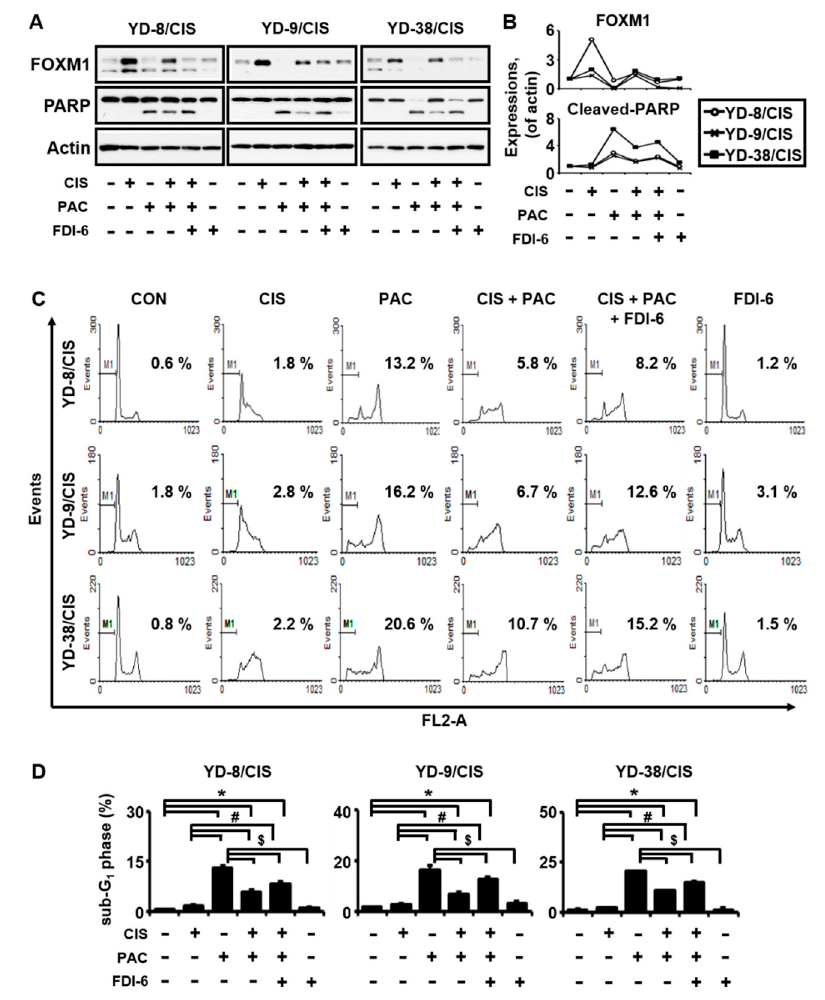
Figure 3. Cisplatin (10 µ g / mL) weakens the chemical sensitivity of paclitaxel (0.1 µ g / mL), whereas co-treatment with FDI-6, a FOXM1 inhibitor, restores it in cisplatin-resistant cell lines. ( A ) The expression of FOXM1, poly (ADP-ribose) polymerase (PARP), and actin in cell lysates from the cisplatin-resistant cell lines treated with cisplatin in the presence and absence of paclitaxel and FDI-6 were determined by Western blot assay. ( B ) Quantification of Western blot results. ( C ) The cytotoxic effect of cisplatin with or without paclitaxel in cisplatin-resistant cell lines was determined by a propidium iodide (PI) staining assay. ( D ) Quantitative results for panel C (mean ± SD; n = 3). * p < 0.05 versus non-treated group, # p < 0.05 versus only cisplatin-treated cells, and $ p < 0.05 versus only paclitaxel-treated cells.